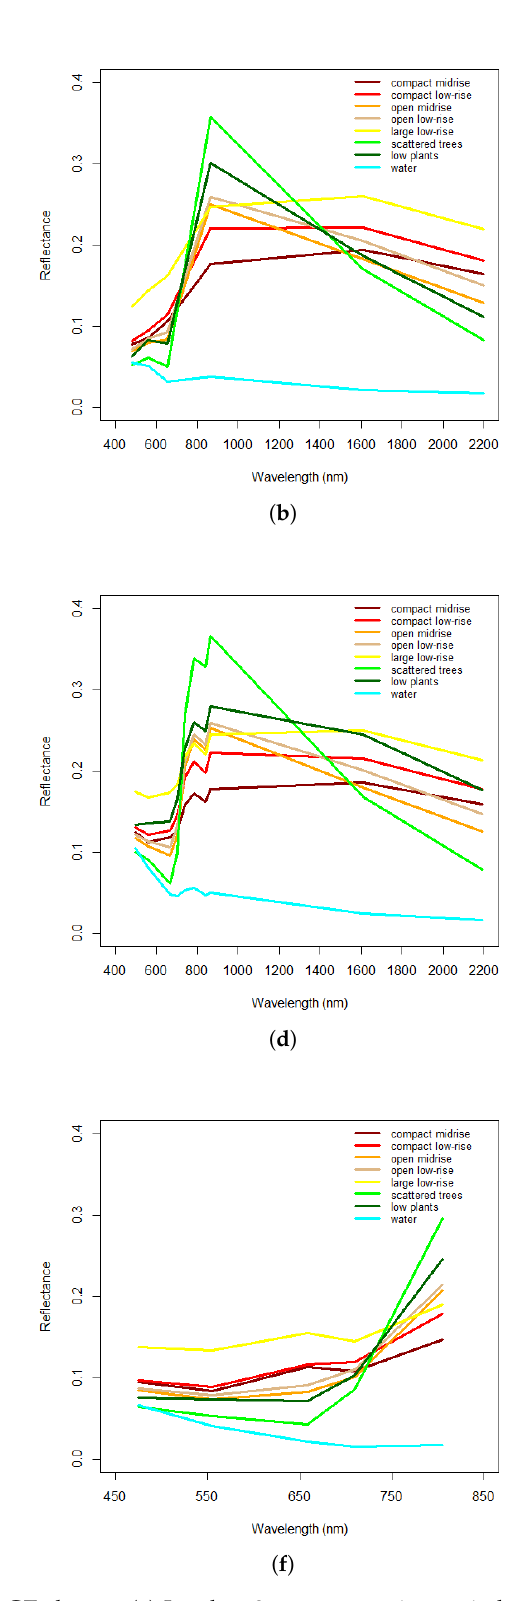
Figure 6. Spectral signatures of the 8 different LCZ classes: ( a ) Landsat 8, non-vegetative period; ( b ) Landsat 8, vegetative period; ( c ) Sentinel-2, non-vegetative period; ( d ) Sentinel-2, vegetative period; ( e ) RapidEye, non-vegetative period, ( f ) RapidEye, vegetative